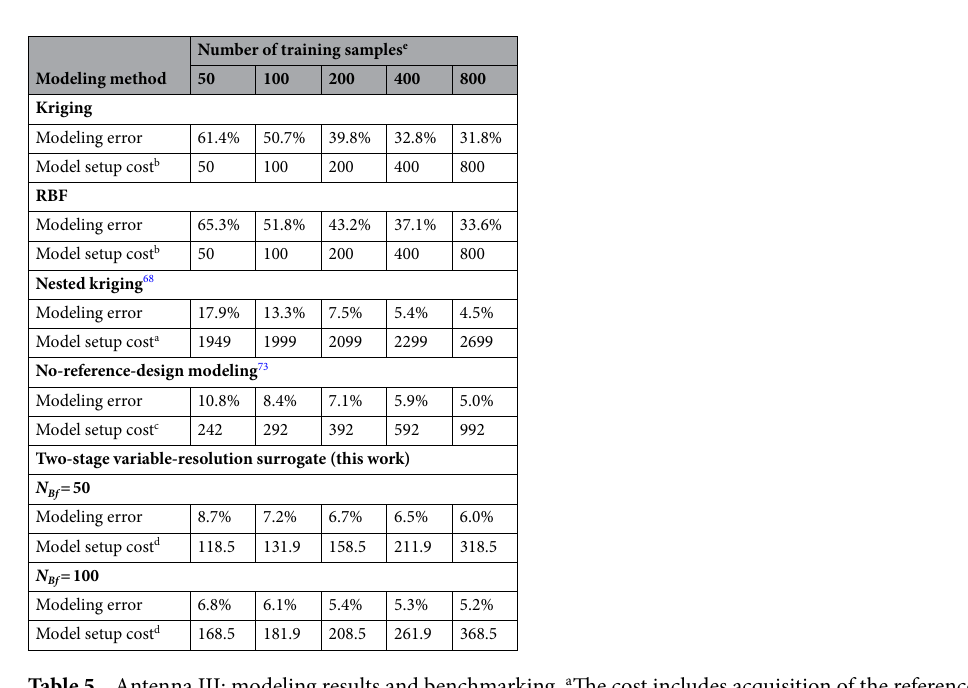
Table 5. Antenna III: modeling results and benchmarking. a The cost includes acquisition of the reference designs, which is 1899 EM high-fidelity simulations of the antenna. b The cost refers to high-fidelity simulations. c The cost includes generation of random trial points, here, 192 high-fidelity simulations in total to yield N r = 50 accepted samples. d The cost includes generation of random trial points at low-fidelity level, here, 207 simulations in total to yield N r = 50 accepted samples. e In the case of the proposed model, the numbers 50 through 800 refer to low-fidelity EM